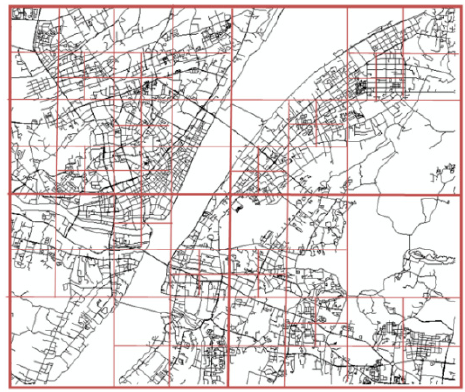
Figure 11. Quadtree-based partition graph of a vector map in dynamic tile clipping.